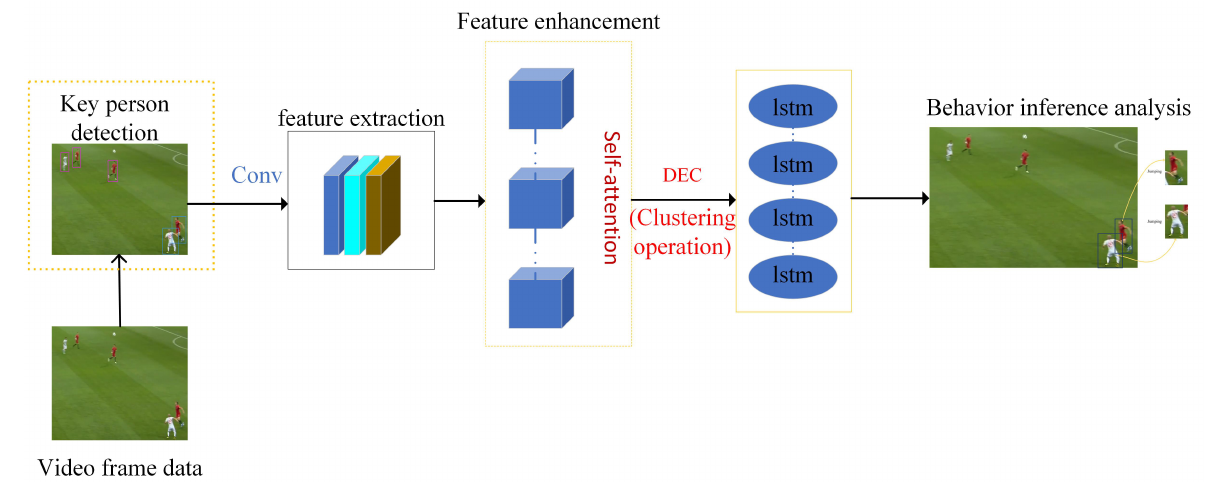
Figure 1. Overall flow chart of algorithm. First, input the video frame data to locate and detect the key people, and then extract the features through convolution. Secondly, incorporate the self attention mechanism here to enhance the features, and then cluster through DEC. Finally, conduct behavior analysis and inference through